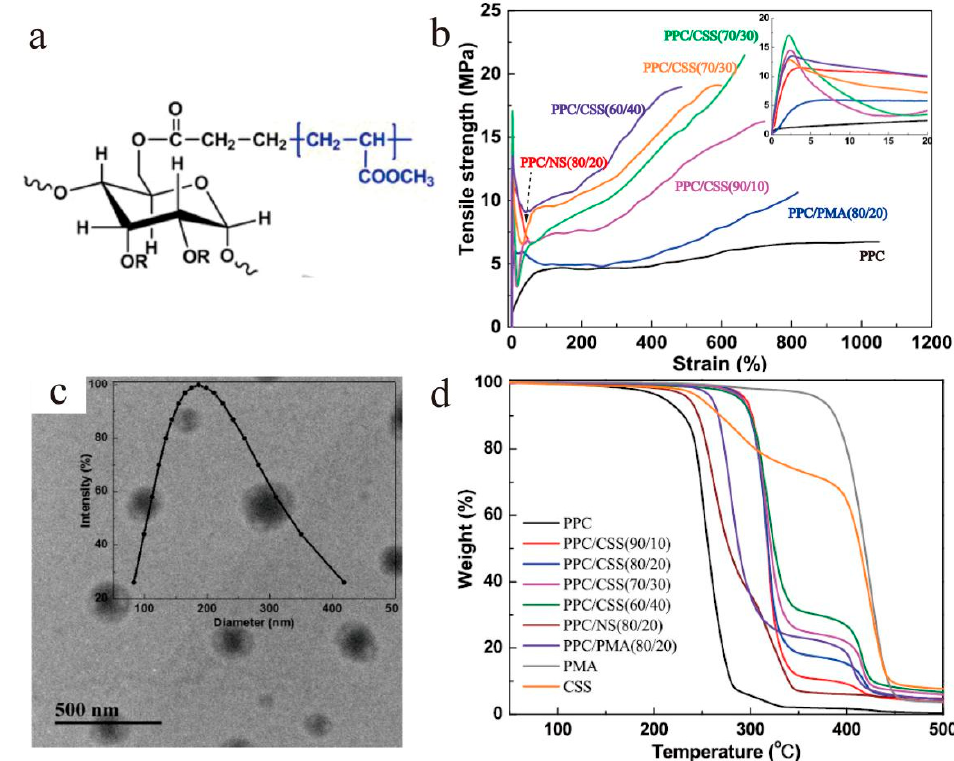
Figure 7. ( a ) Molecular structure of PMA grafted starch; ( b ) stress − strain curves of PPC, PPC/core–shell starch (CSS), PPC/native starch (NS), and PPC/PMA (propylene glycol methyl ether acetate) composites; ( c ) TEM image of core–shell starch nanoparticles (CSS NPs); ( d ) thermo gravimetric analysis (TGA) curves of samples [50]. Reproduced with permission from [Li Liu et al.], [ACS Sustainable Chemistry & Engineering]; published by [American Chemical Society], 2019.